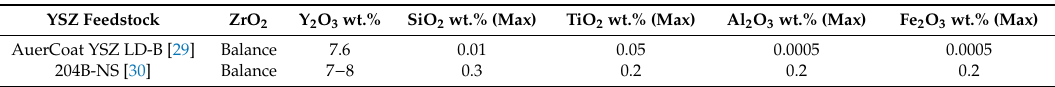
Table 1. Chemical compositions of YSZ feedstock powders: AuerCoat YSZ LD-B (high purity) [29] and 204B-NS [30] (conventional purity).